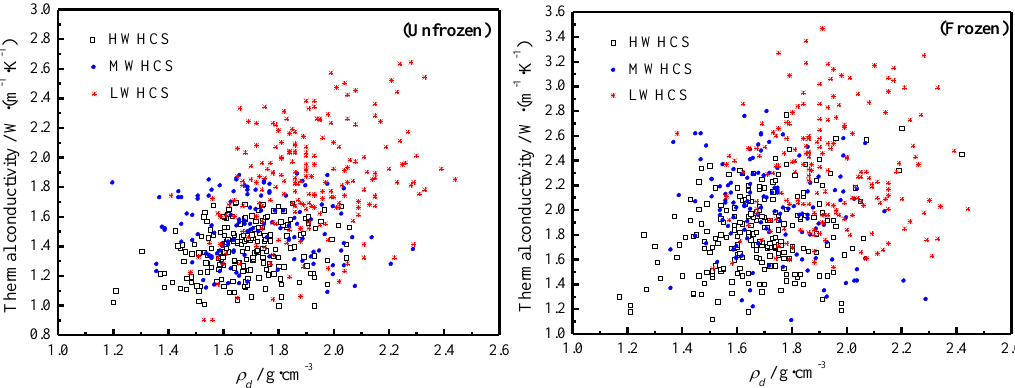
Figure 9. Thermal conductivities of three soil clusters with different dry density.